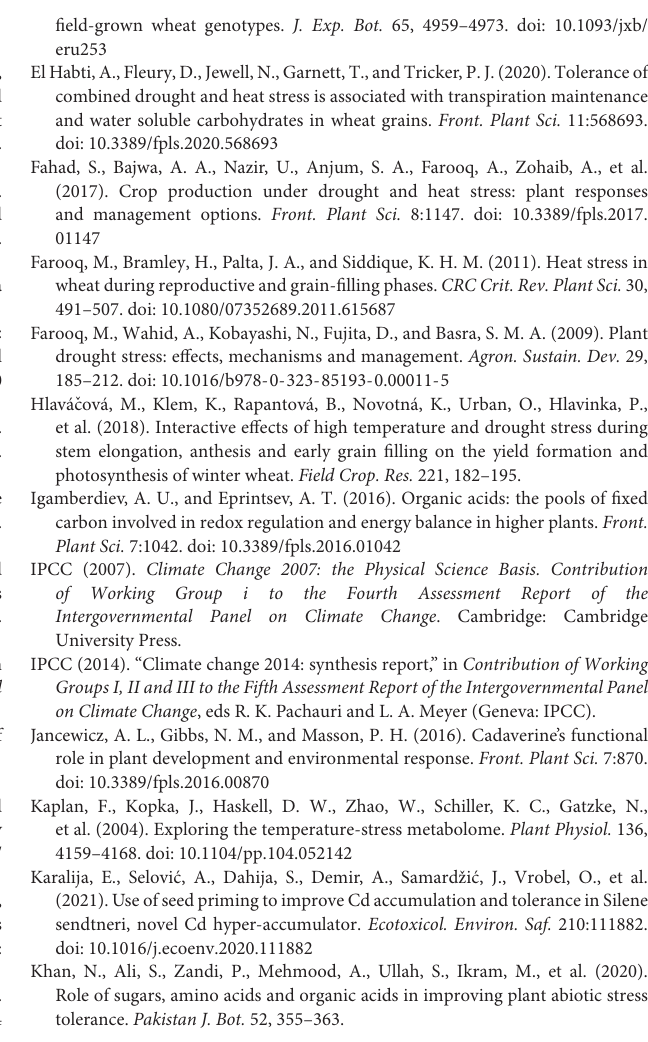
Supplementary Figure 4 | Fitted parameters from the light response curves; (A) light compensation point (LCP) and (B) convexity of the curve ( θ ), and leaf reflectance represented as (C) photochemical reflectance index (PRI) in heat-sensitive (SF29) and heat-tolerant (LM20) genotypes grown under control conditions (C), heat stress at Day 4 (H4), at Day 7 (H7) and combined heat stress and drought at Day 7 (D + H7) at ambient CO 2 (aCO 2 ) or elevated CO 2 (eCO 2 ). The data represent mean values ± standard error (S.E.) ( n = 6–8). Different small letters indicate significant differences within variants according to Duncan’s test after ANOVA ( p < 0.05). Supplementary Figure 5 | Morphological and grain traits from destructive harvest at ripening. (A,B) Number of spikes and tillers per plant, (C–E) dry weight of spikes, tillers, and leaves per plant and (F–H) Grain dimensions including area, width, and length in heat-sensitive (SF29) and heat-tolerant (LM20) genotypes grown under control conditions (C), heat stress at Day 4 (H4), at Day 7 (H7), and combined heat stress and drought at Day 7 (D + H7) at ambient CO 2 (aCO 2 ) or elevated CO 2 (eCO 2 ). The data represent mean values ± standard error (S.E.) ( n = 6–8). Different small letters indicate significant differences within variants according to Duncan’s test after ANOVA ( p <